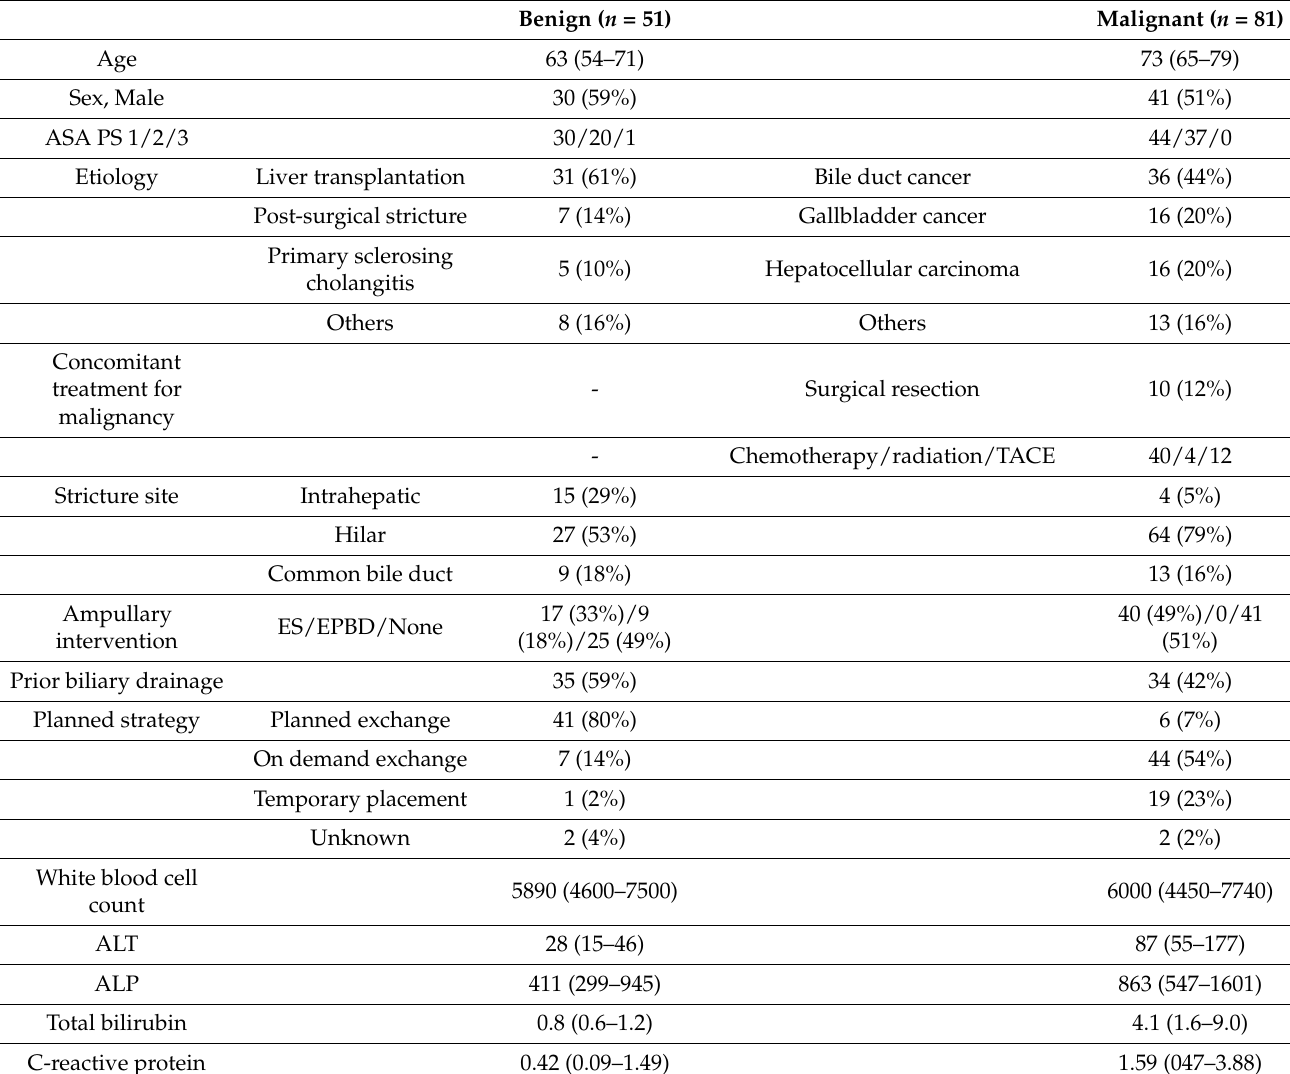
Table 1. Patient